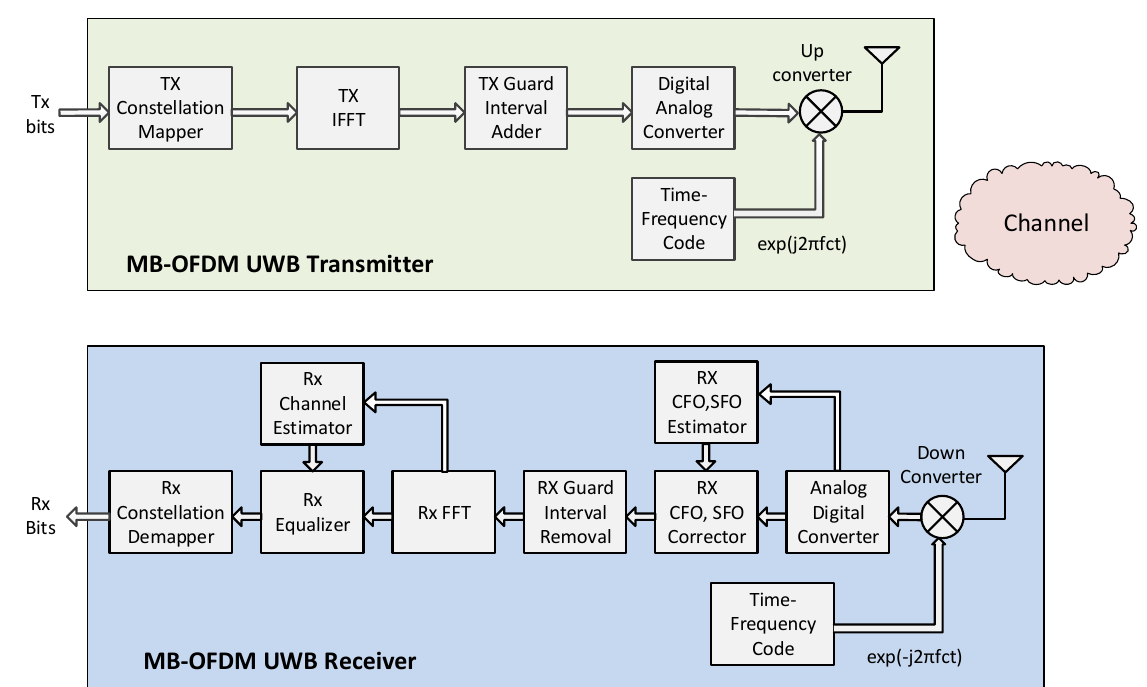
Figure 4. Multi-Band Orthogonal Frequency Division Multiplexing UWB (MB-OFDM UWB)